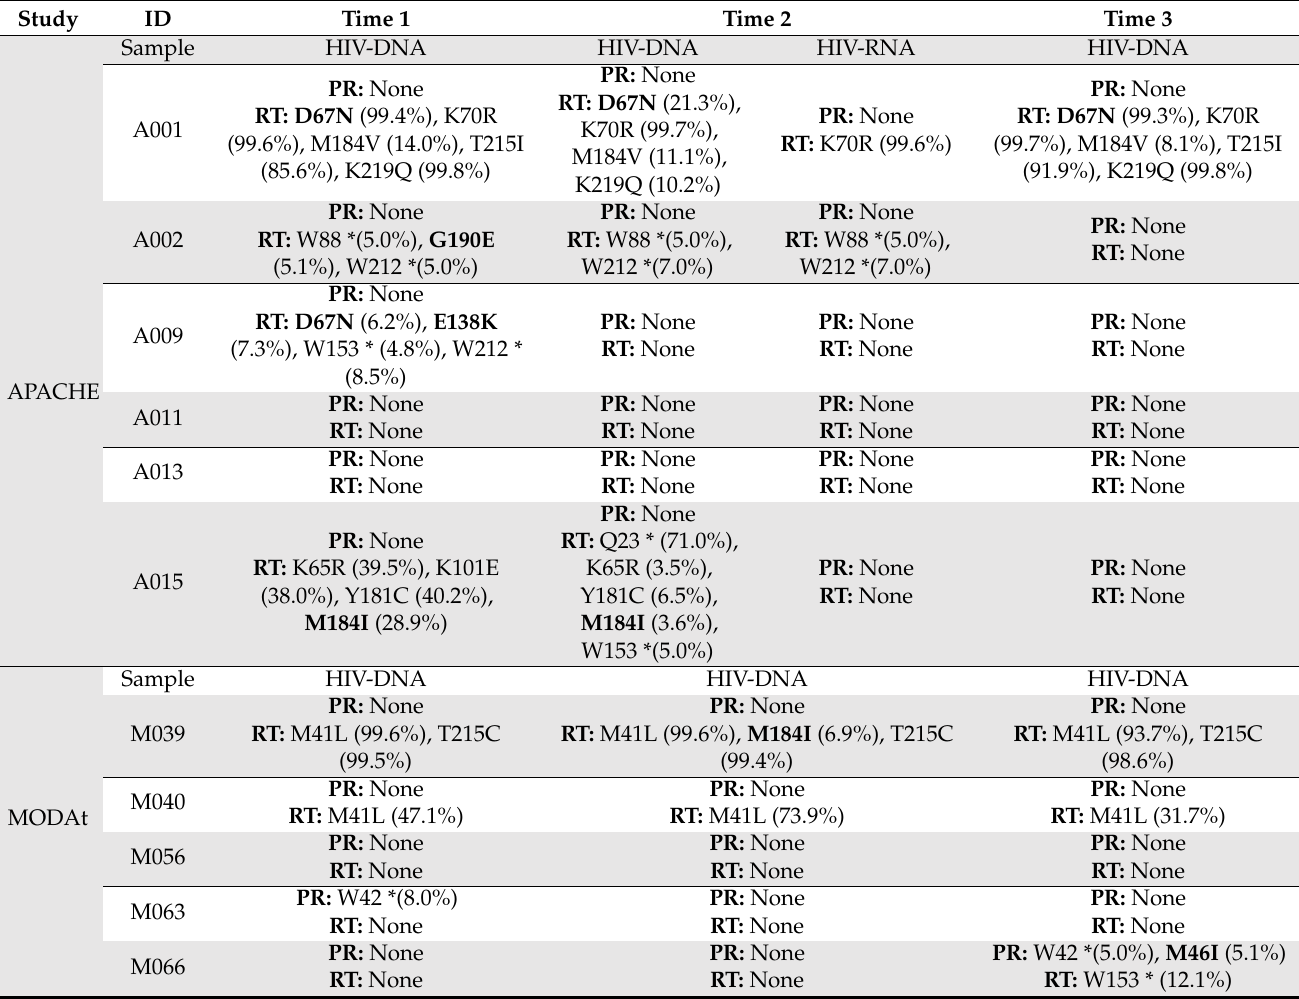
Table 2. Major drug resistance mutations and stop-codons in protease and reverse transcriptase found in APACHE and MODAT participants at different time